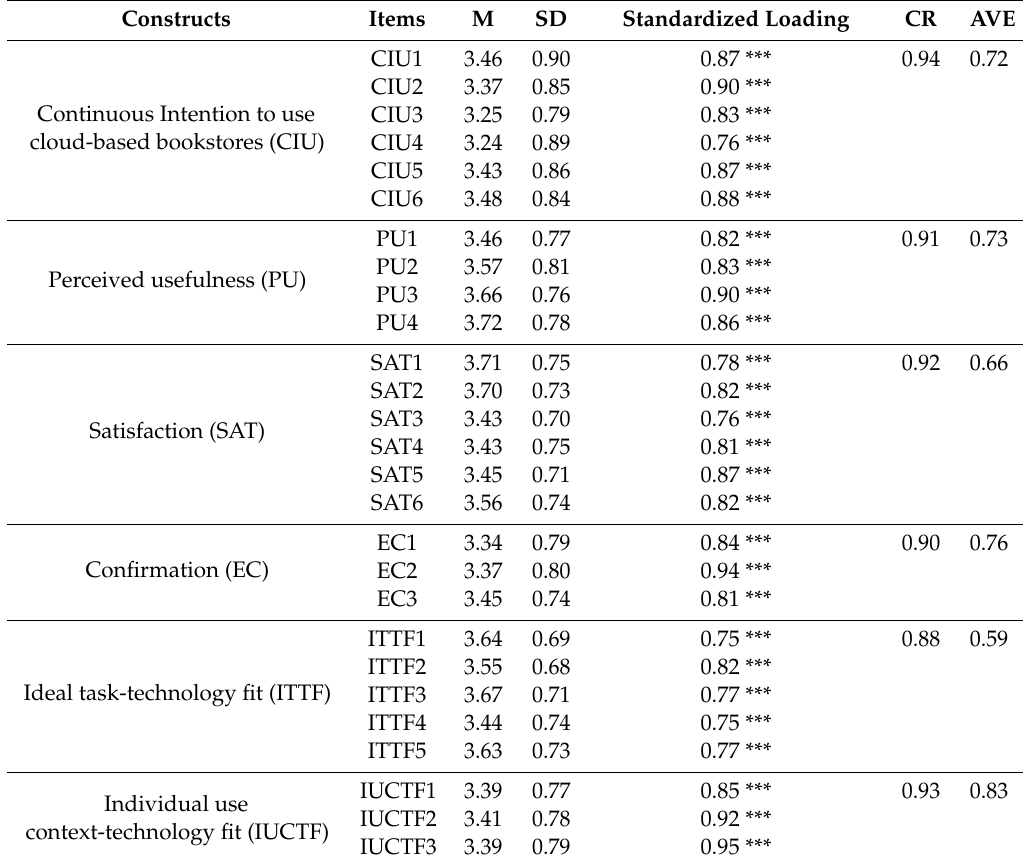
Table 5. Confirmatory factor analysis and scale reliability.